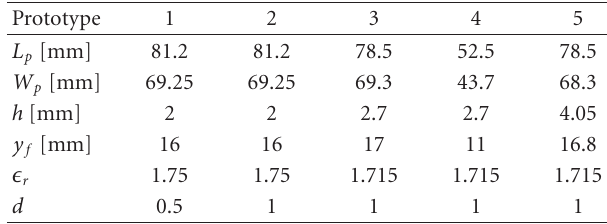
Table 1: Parameters of the prototypes.